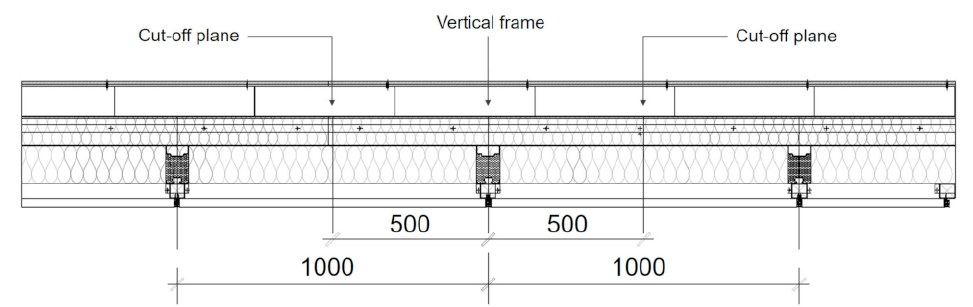
Figure 6. Location of cut-off planes for simulation.